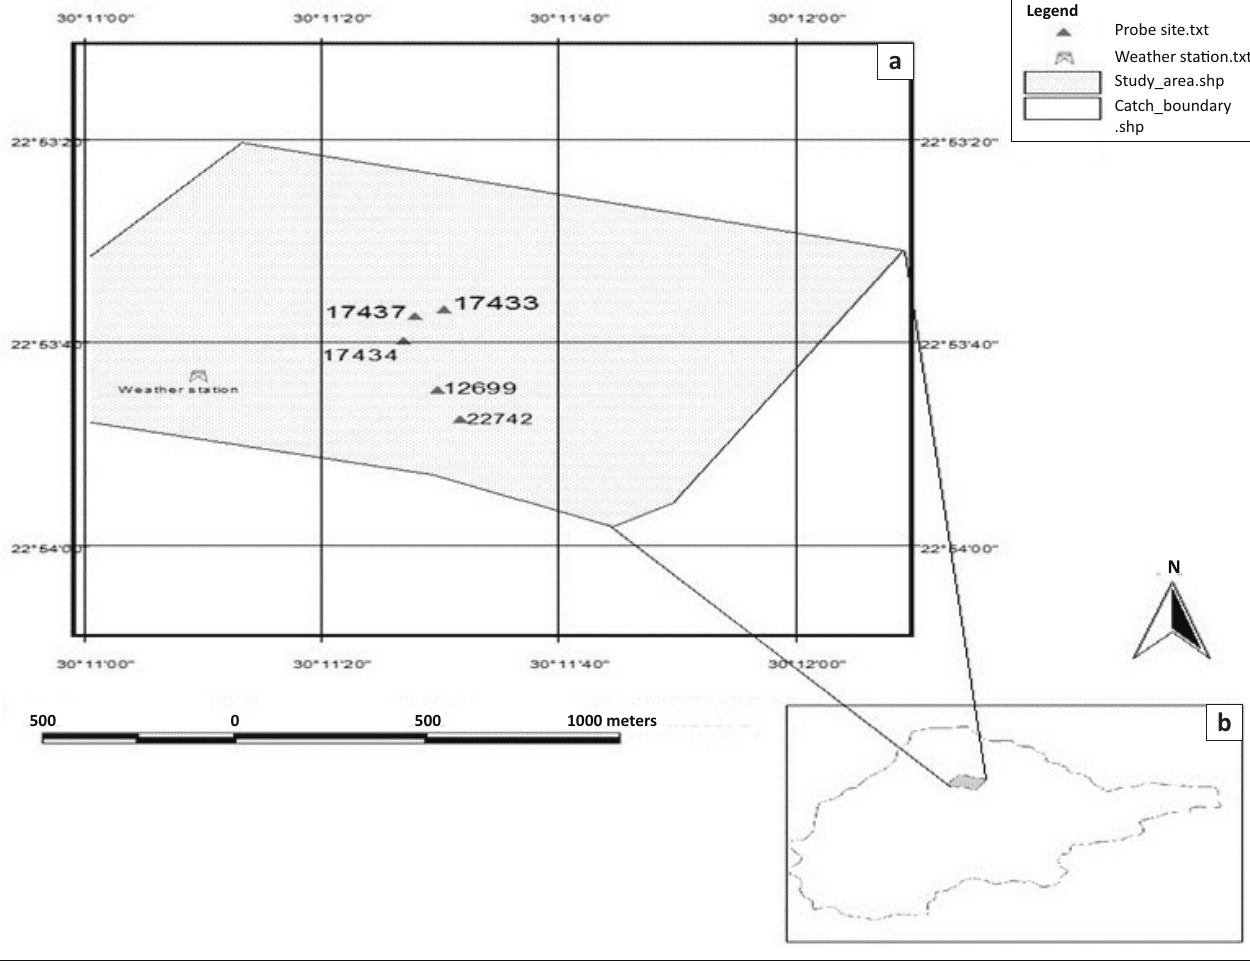
FIGURE 3: (a & b) Map showing the Nzhelele quaternary catchment monitoring